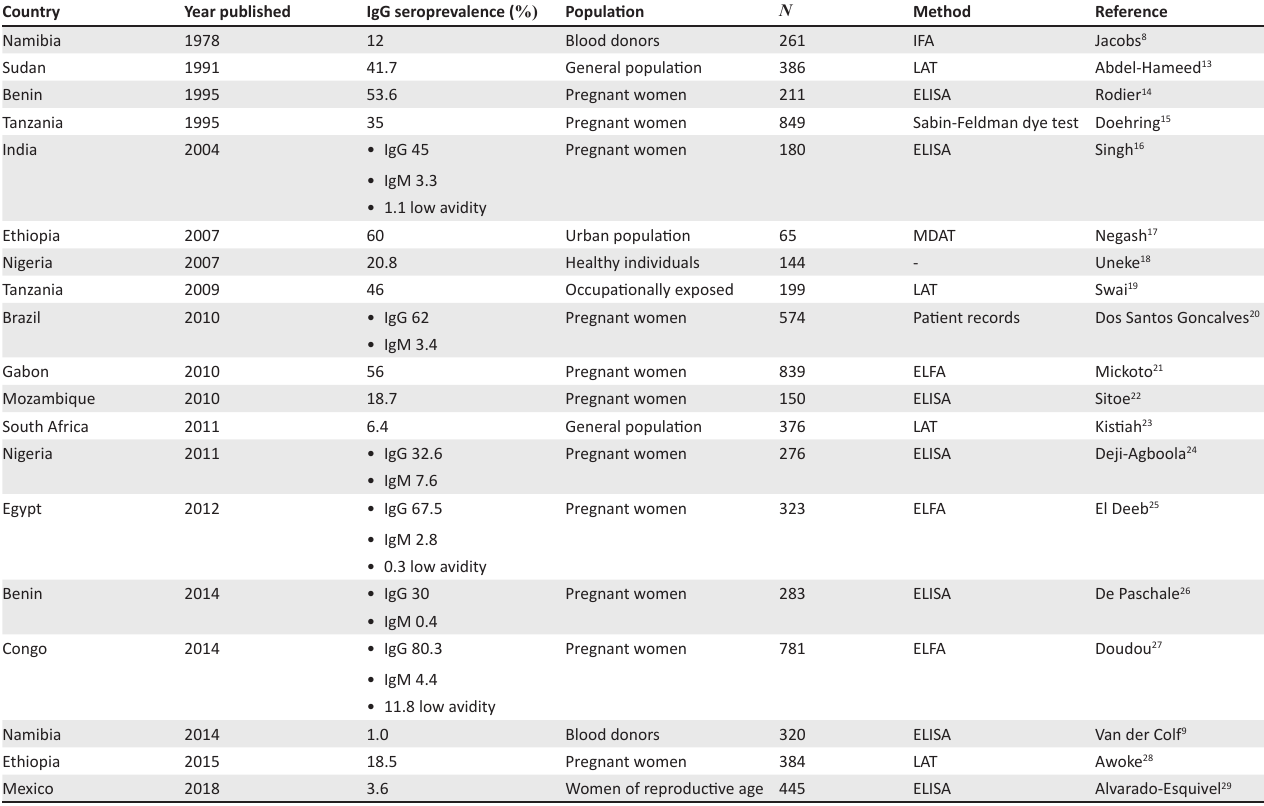
TABLE 4: Seroprevalence of Toxoplasma gondii in developing countries. Country Year published